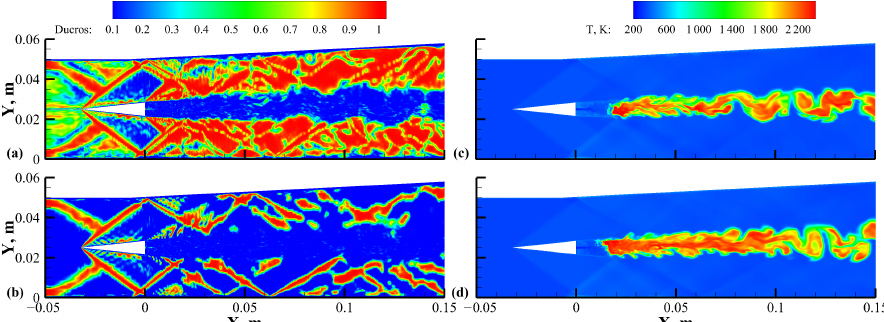
Figure 19. Contours of the blending functions of the original and modified low-dissipation schemes ( a ) M1 and ( b ) M2, and the temperature distributions of these two schemes ( c ) M1 and ( d )